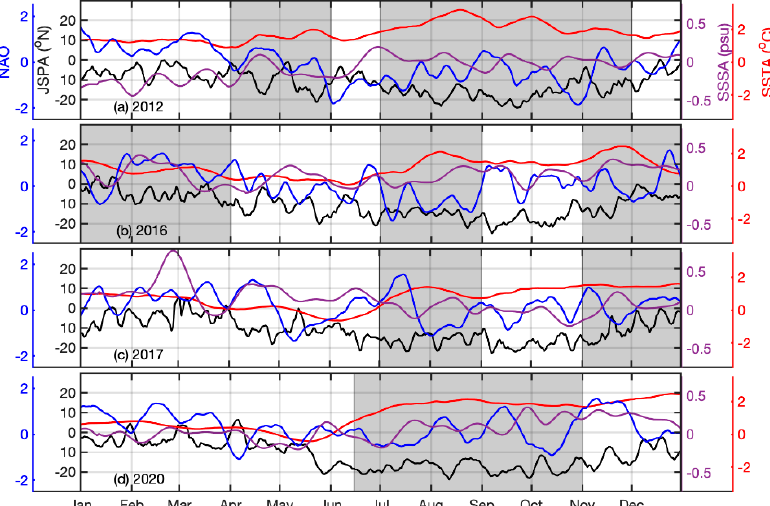
Figure 10. Time series showing JS latitude (°N) (black), average SSTA (°C) (red), North Atlantic Oscillation index (blue), and average SSSA (psu) (purple) for 2012 ( a ), 2016 ( b ), 2017 ( c ), and 2020 ( d ). SSTA and SSSA averages were taken over 40–48°N and 70–48°W. Jet Stream Position Anomaly (JSPA) was calculated from the daily latitude minus the mean latitude of the daily strongest winds at 300 hPa averaged across 70–48°W in the North Atlantic. Time series was smoothed with the moving average.